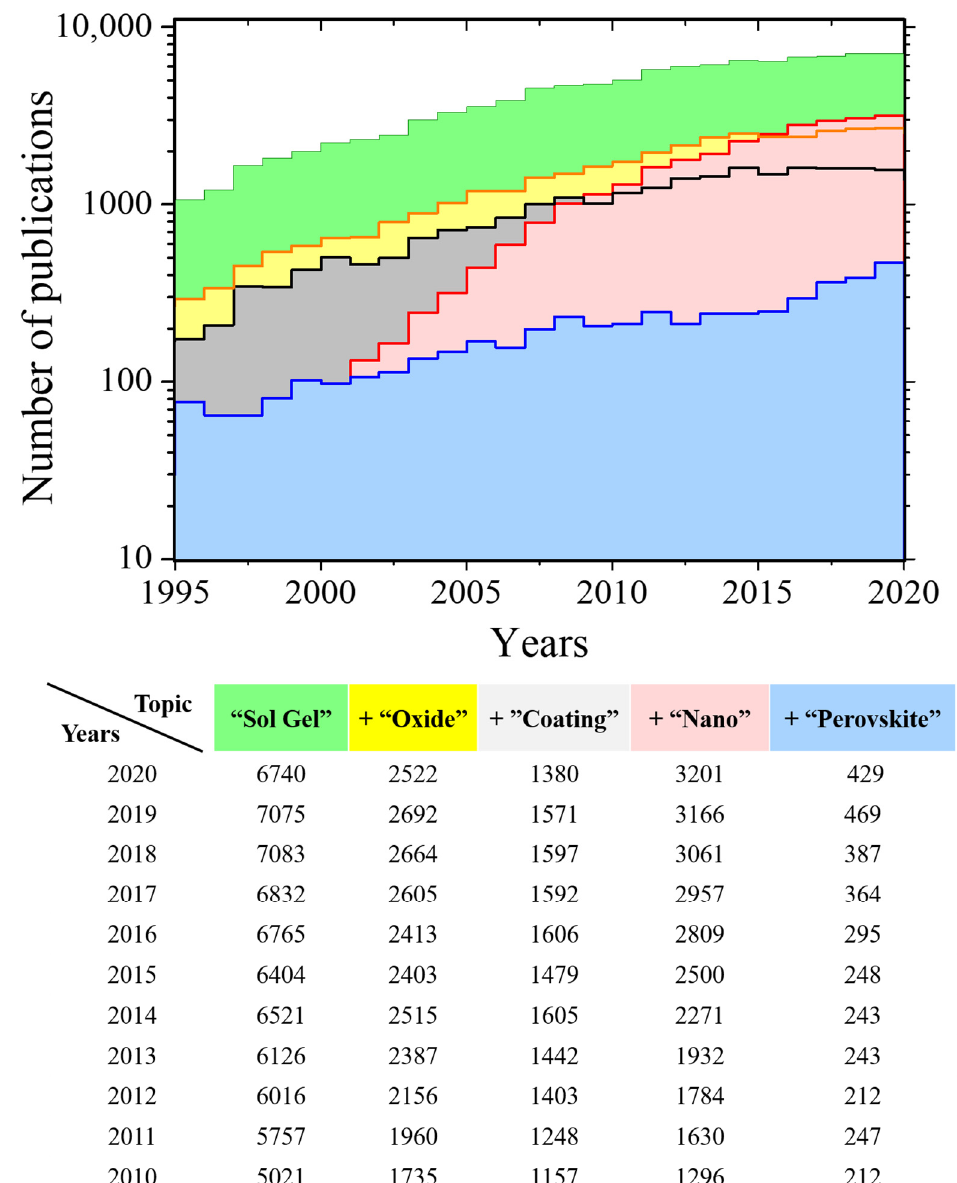
Figure 1. Top: Number of publications in the last 25 years including the keywords “Sol-Gel” (green), “Sol-Gel” + “oxide” (yellow), “Sol-Gel” + “coating” (grey), “Sol-Gel” + “nano” (red) and “Sol-Gel” + “perovskite” (blue). Bottom: table of number of publication in the with the number of publication in 2020–2010 period. All the data was extracted from web of science [17].